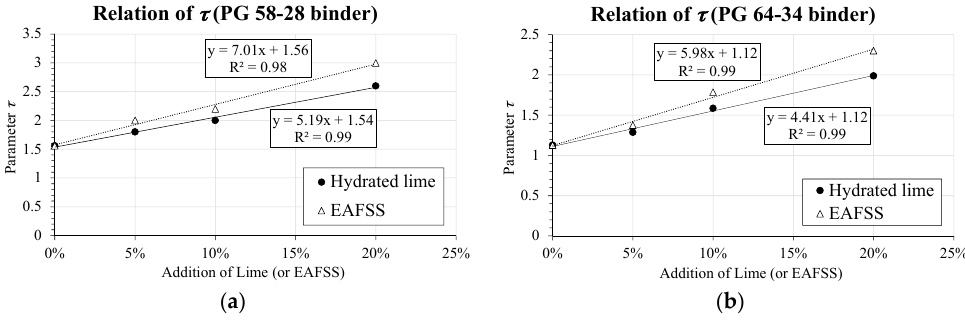
Figure 8. Relation between τ and aggregate particle content. ( a ) Relation of τ (PG 58-28 binder); ( b ) Relation of τ (PG 64-34 binder).